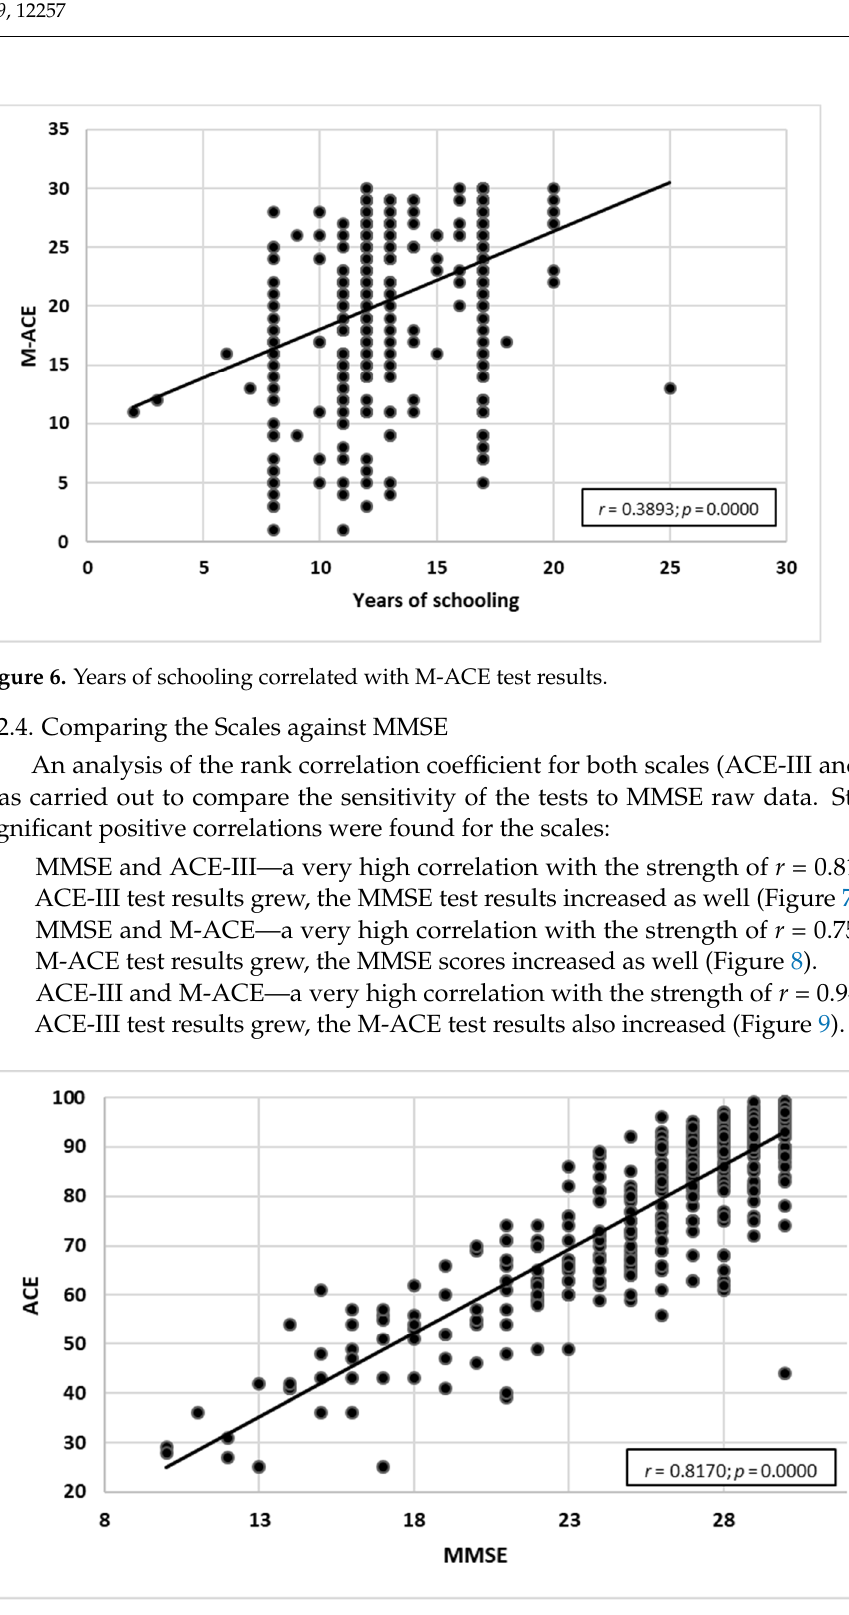
Figure 5. Age correlated with M-ACE test results.